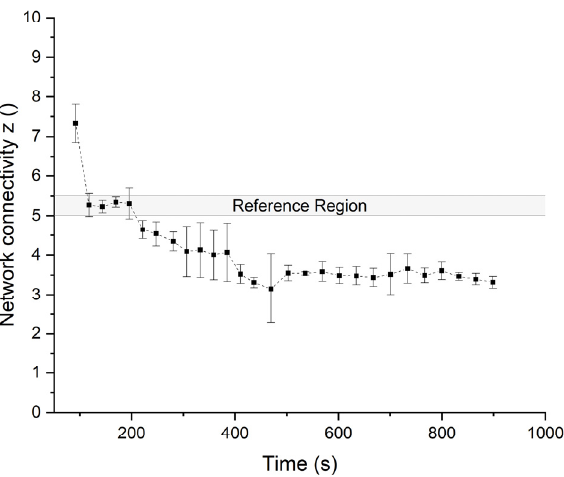
Figure 7. Network connectivity z from power-law fitting G*. Measured in an additional test setup via multiwave frequency sweeps after certain relaxation steps during stepwise increases in shear kneading. The reference region (z = 5 to 5.5) shows the range of values of a Z-kneaded dough at its dough development time (150 s). Means are shown with standard deviation (n = 3).